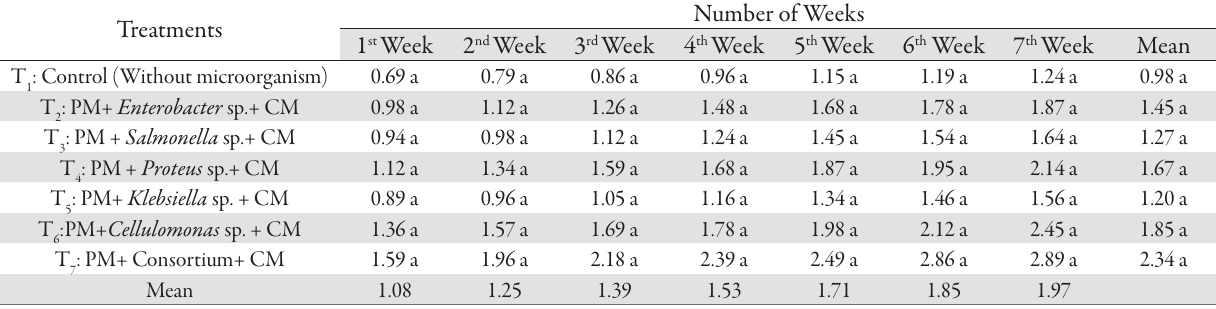
Tab. 2. Changes of Nitrogen percent during composting of press mud with cattle manure Treatments